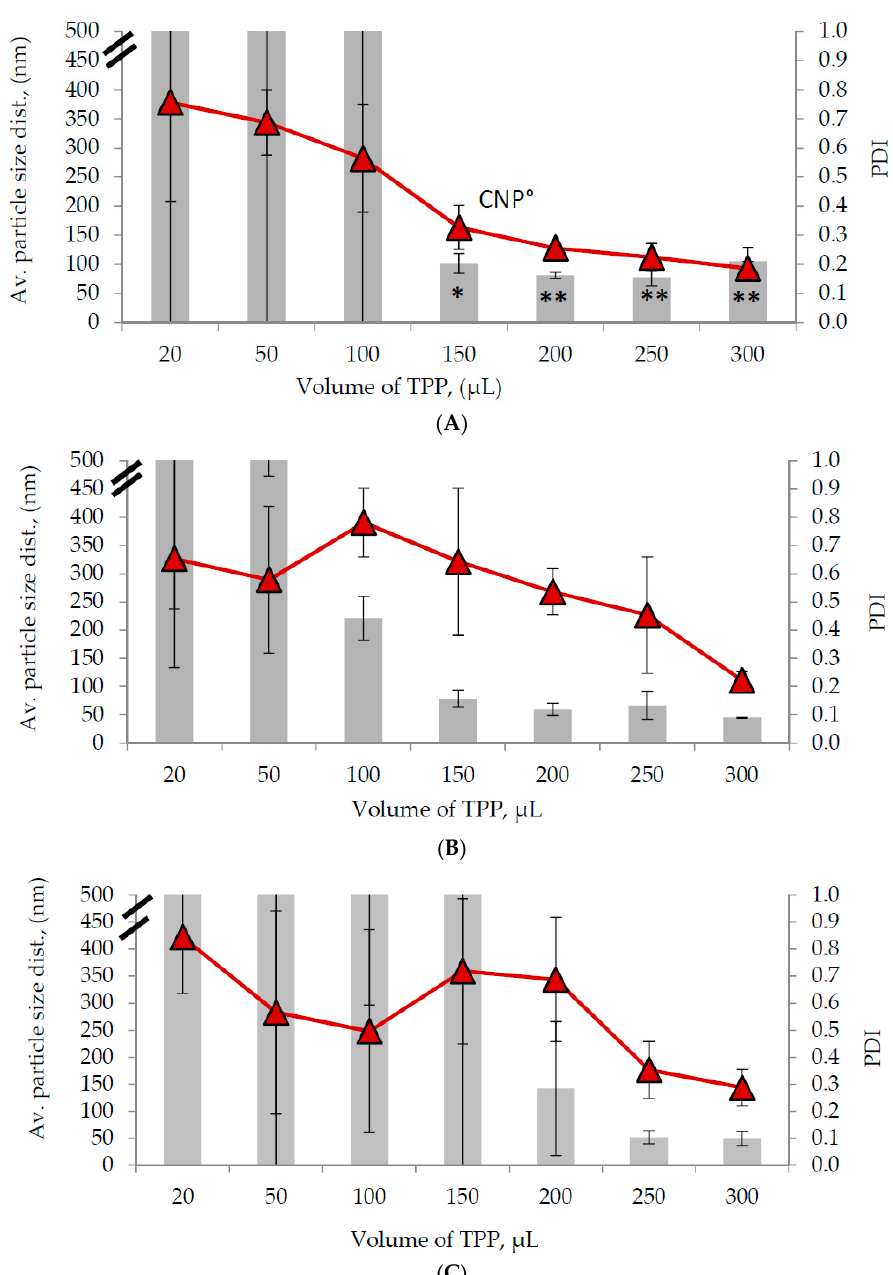
Figure 2. The influence of TPP volume of ( A ) CNP-F1, ( B ) CNP-F2, and ( C ) CNP-F3 on average particle size distribution (diameter in nm, nm), and polydispersity index (PDI). The average particle size distribution was illustrated in graph bar and PDI was illustrated in line graph. CNP° represents the optimal parameter required to synthesize stable and evenly distributed nanoparticle sizes. Error bars represent the SD of three independent replicates of the experiment. * shows degree of significant difference, P < 0.0015 compared to 20 µL of TPP volume.